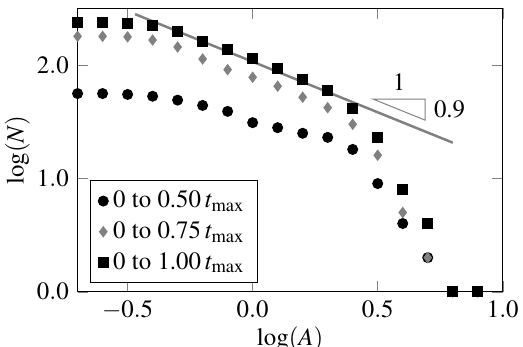
Figure 14. N ( A ) —histograms from the AE— test results, taking into account 50%, 75%, and 100% of observed events.